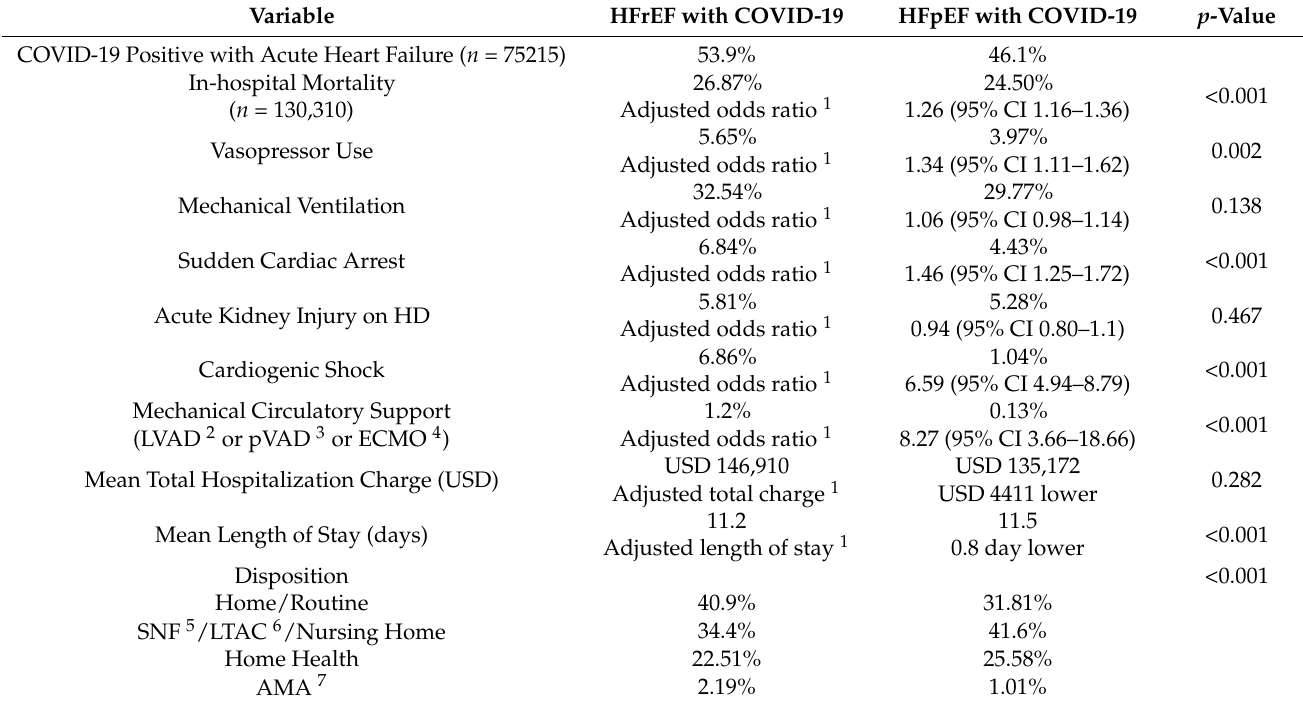
Table 5. In-hospital outcomes in COVID-19 Positive patients with Heart Failure with